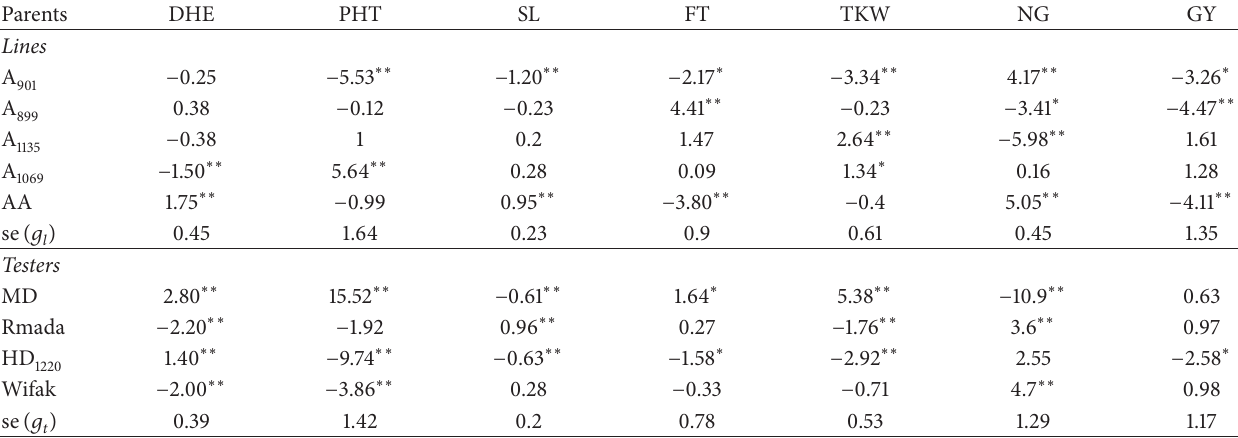
Table 4: General combining ability (gi) effects for characters in bread wheat